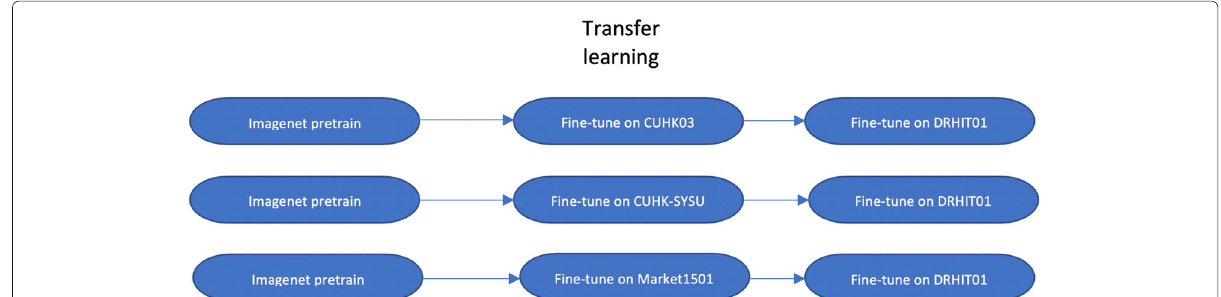
Fig. 4 The flow diagram of experiments with transfer learning. The baseline does not have transfer learning part and network directly fine-tuned on the DRHIT01